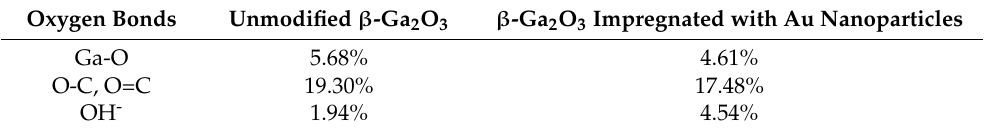
Figure 7. XPS spectra in the O1s region of: ( a ) unmodified β -Ga 2 O 3 epitaxial layer; ( b ) β -Ga 2 O 3 epitaxial layer modified with Au nanoparticles. Table 1. Oxygen bonds’ atomic concentration in O1s region.